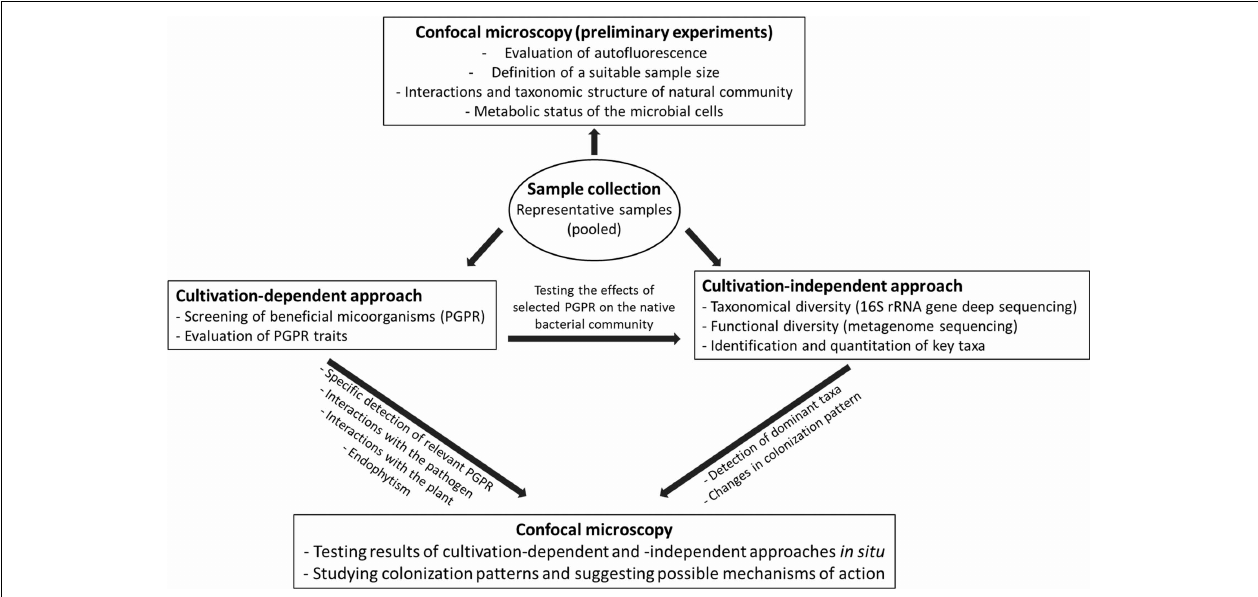
FIGURE 4 | Integration of CLSM with other techniques. The workflow shows the combination of CLSM with other methods for plant-microbes interactions studies. A case study of PGPR is used in this